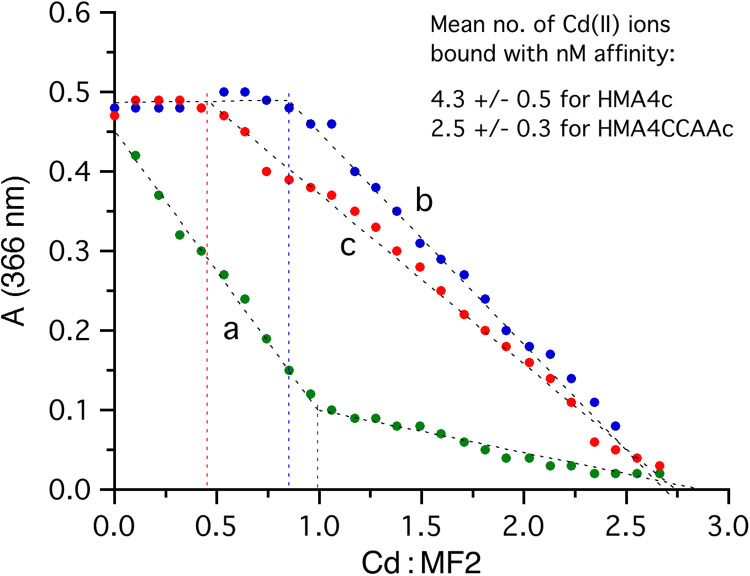
Cd(II)-binding assay for the AtHMA4 C-terminal domains by competition with MF2 probe in MOPS buffer (pH 7.3, 100 mM NaCl, 1 mM TCEP): curve (a) titration of MF2 (16.2 μM) with CdCl2 (200 μM); curve (b) titration of a mixture of MF2 (16.2 μM) and MBP-AtHMA4c (3.4 μM) with CdCl2 (200 μM); curve (c) titration of a mixture of MF2 (16.2 μM) and MBP-AtHMA4CCAAc (3.3 μM) with CdCl2 (200 μM). The apparent turning point for each titration curve is indicated by a vertical dashed line. The number of Cd(II) ions bound to each protein domain with affinities out-competing that of MF2 was estimated by the product of the molar ratio Cd(II)/MF2 at the titration turning point and the molar ratio MF2/protein in the titration mixture. Values in the chart represent data from one experiment representative of three independent experiments, whereas values in the table insert are means ± SD of the three independent experiments.